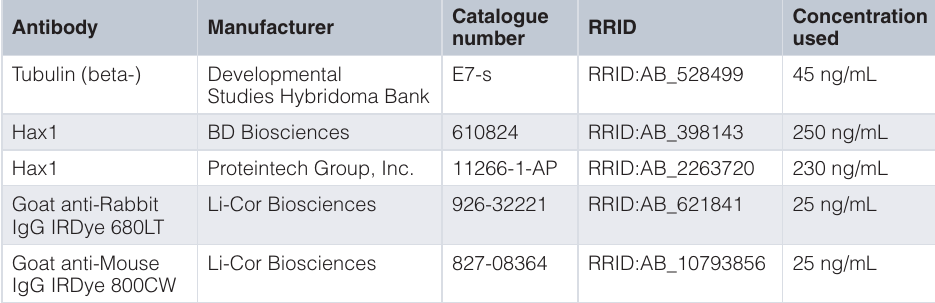
Table 2. Details of Primary and Secondary